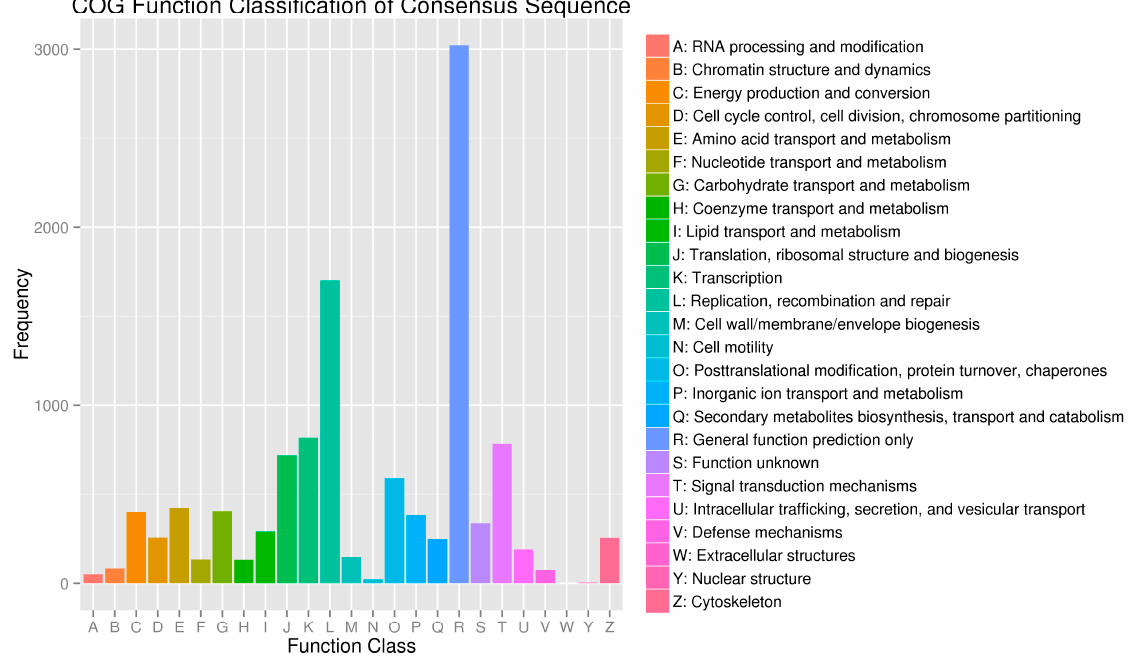
Figure 5. COG function classification of differentially expressed genes in YL and GY skin color of A. davidianus . The horizontal coordinate is the classification content of COG, and the ordinate is the number of genes. In different functional categories, the proportion of genes reflects metabolic or physiological preferences in the corresponding period and environment, which can be explained scientifically based on the distribution of research objects in each functional category.